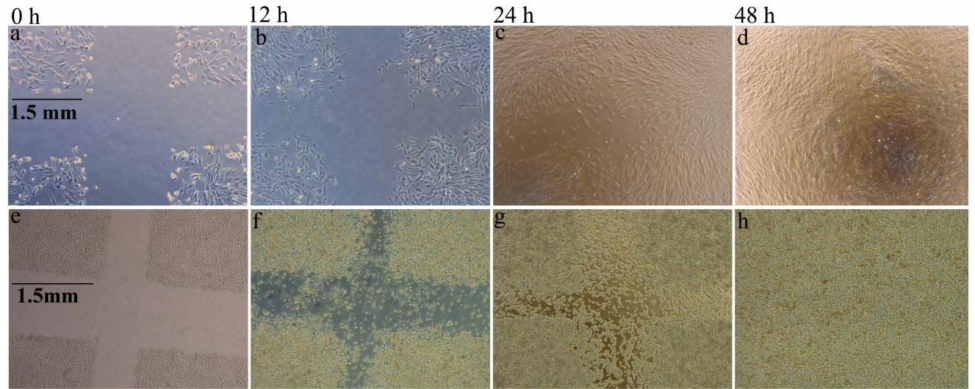
Figure 11. The migration of fibroblasts ( a – d ) and keratinocytes ( e – h ) covered on the simulated scratch wound